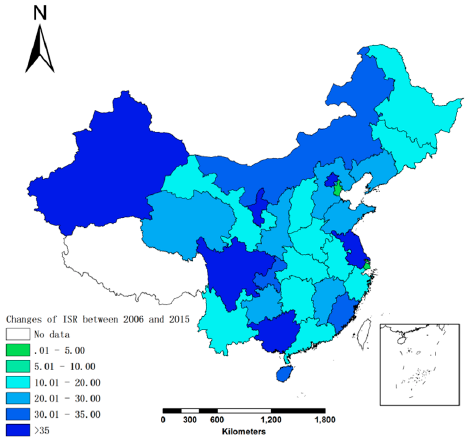
Figure 2. The changes of ISR between 2006 and 2015.